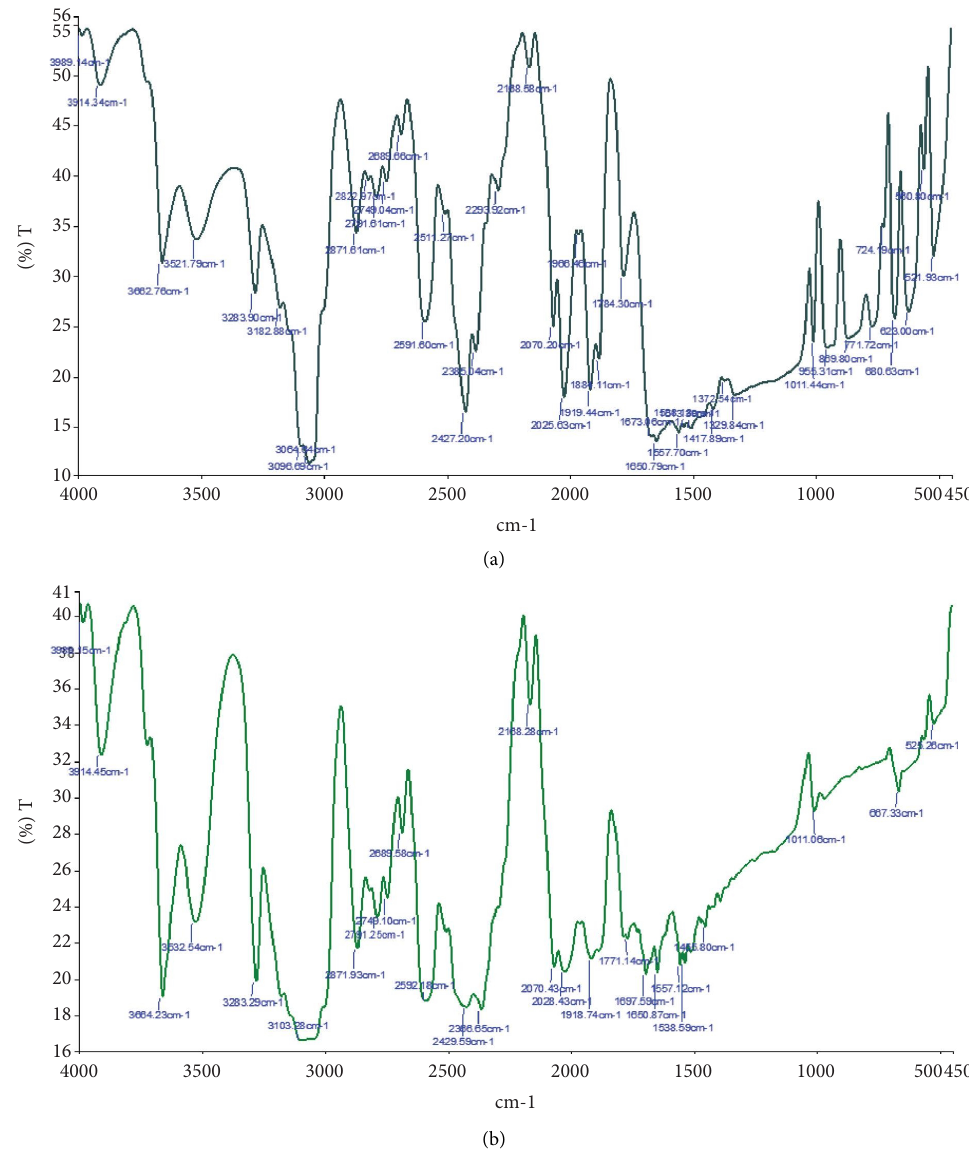
Figure 6: (a) FTIR transmittance spectrum SiO 2 /PEEK and (b) FTIR transmittance spectrum of PEEK.